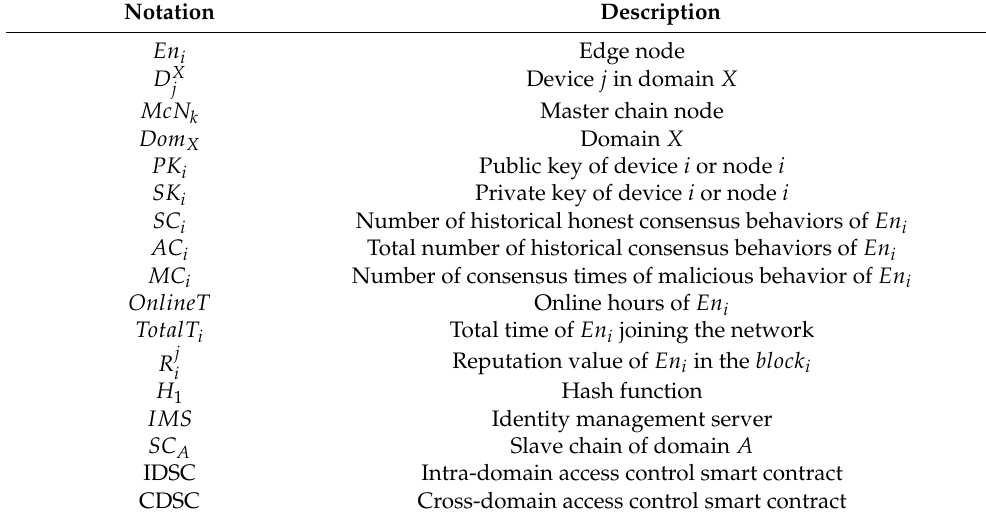
Table 2. A summary of the